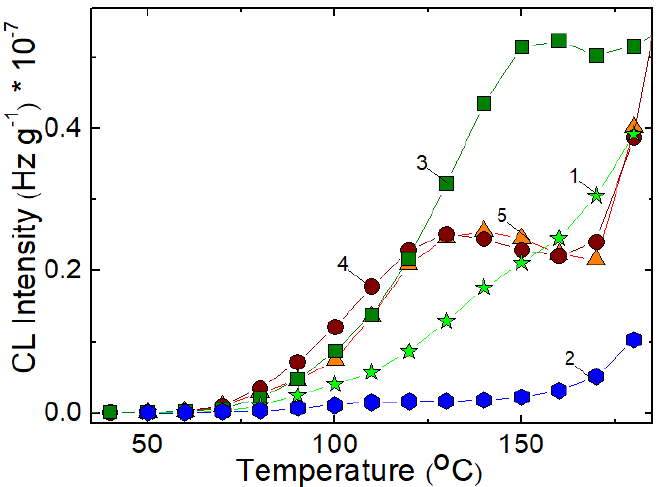
Figure 6. The development of oxidation on the low temperature range for PCL/SIS samples irradiated at 50 kGy: (1) neat PCL, (2) neat SIS, (3) PCL:SIS = 3:1, (4) PCL:SIS = 1:1, (5) PCL:SIS = 1:3.